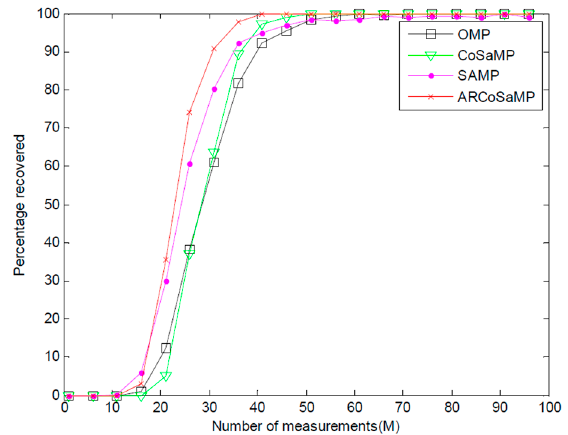
Figure 4. Probability of exact recovery versus the number of measurements.